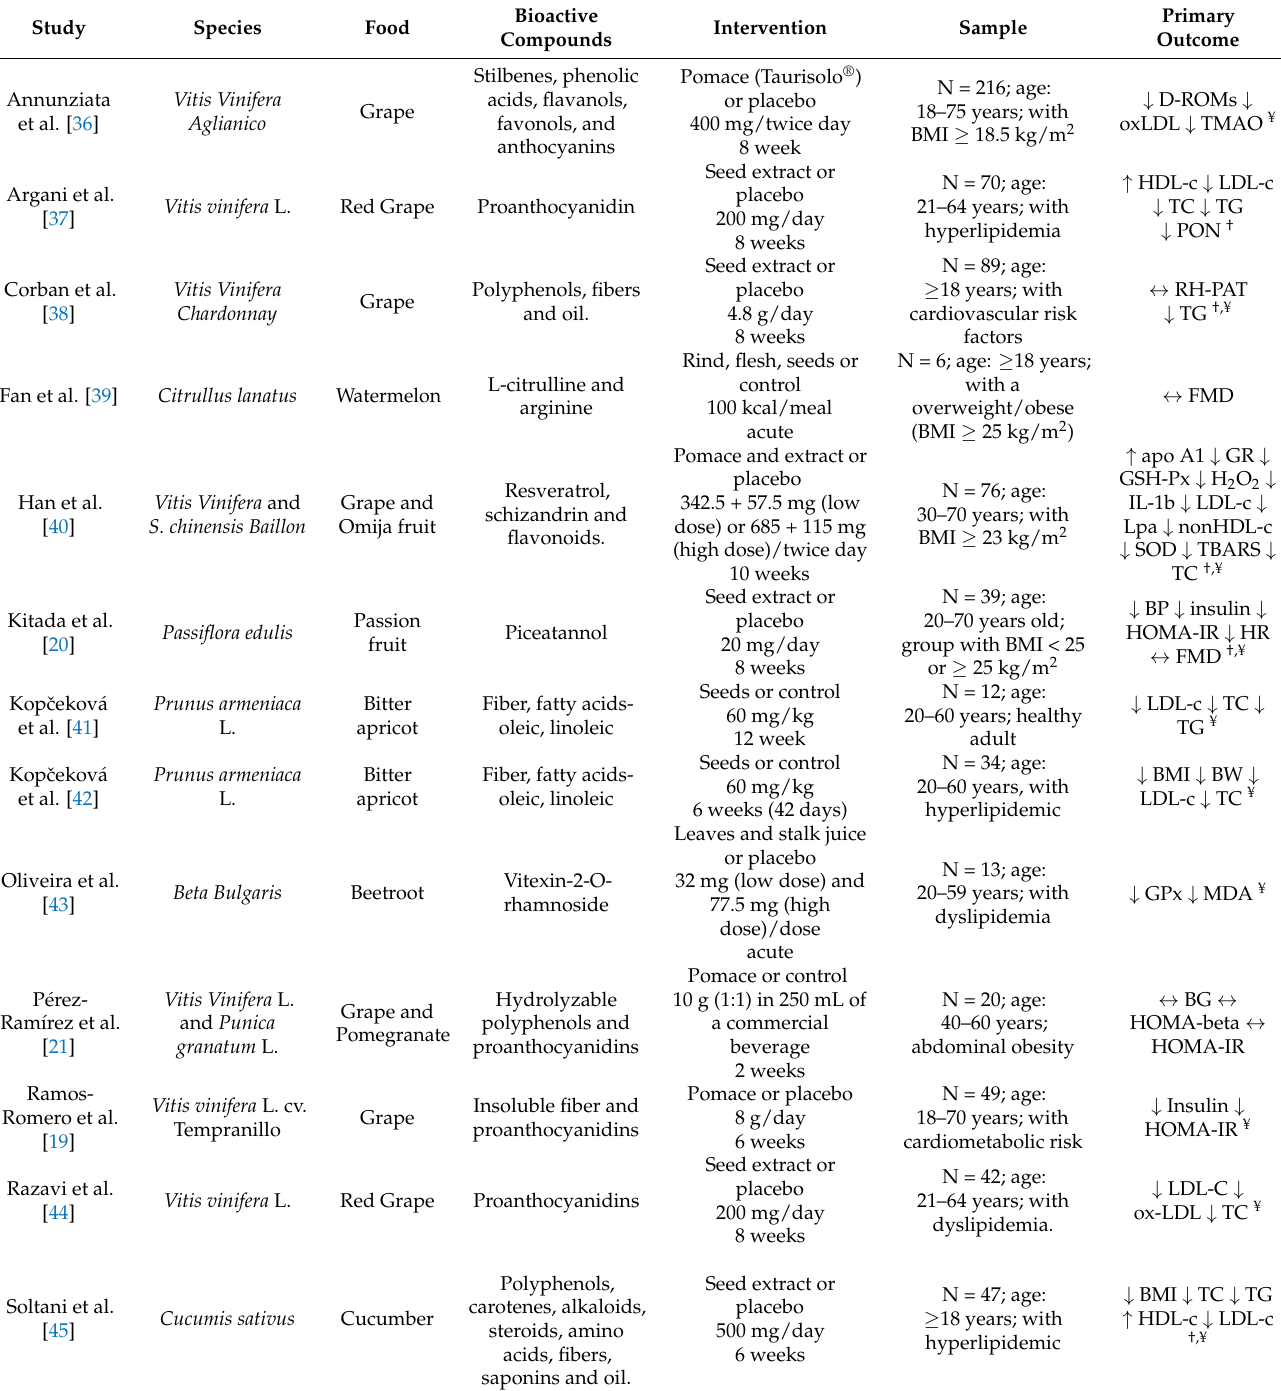
Table 2. Summary of the studies included in the review that investigated the supplementation of fruit or vegetable-based by-products in human